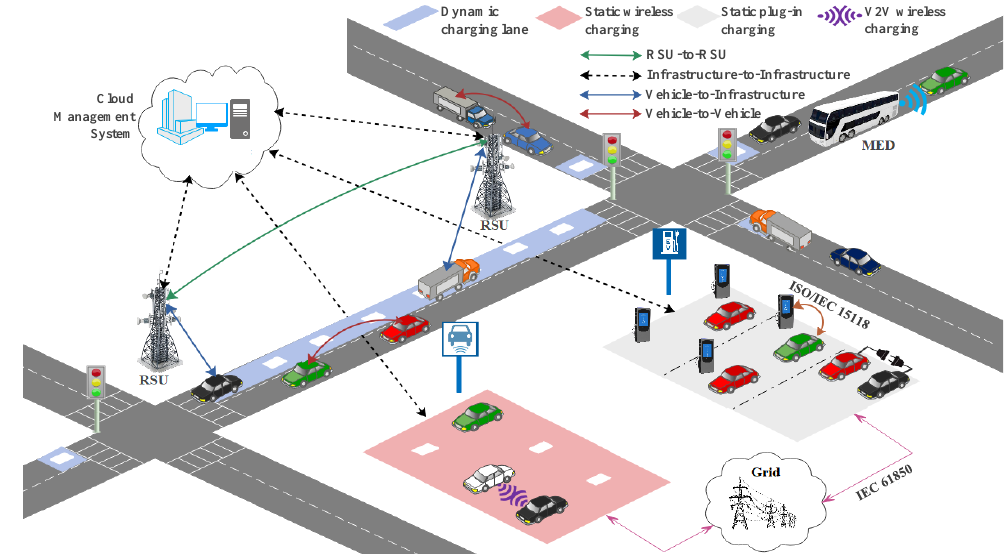
Figure 1. Overview of EV charging solutions in an IoEV within a smart city